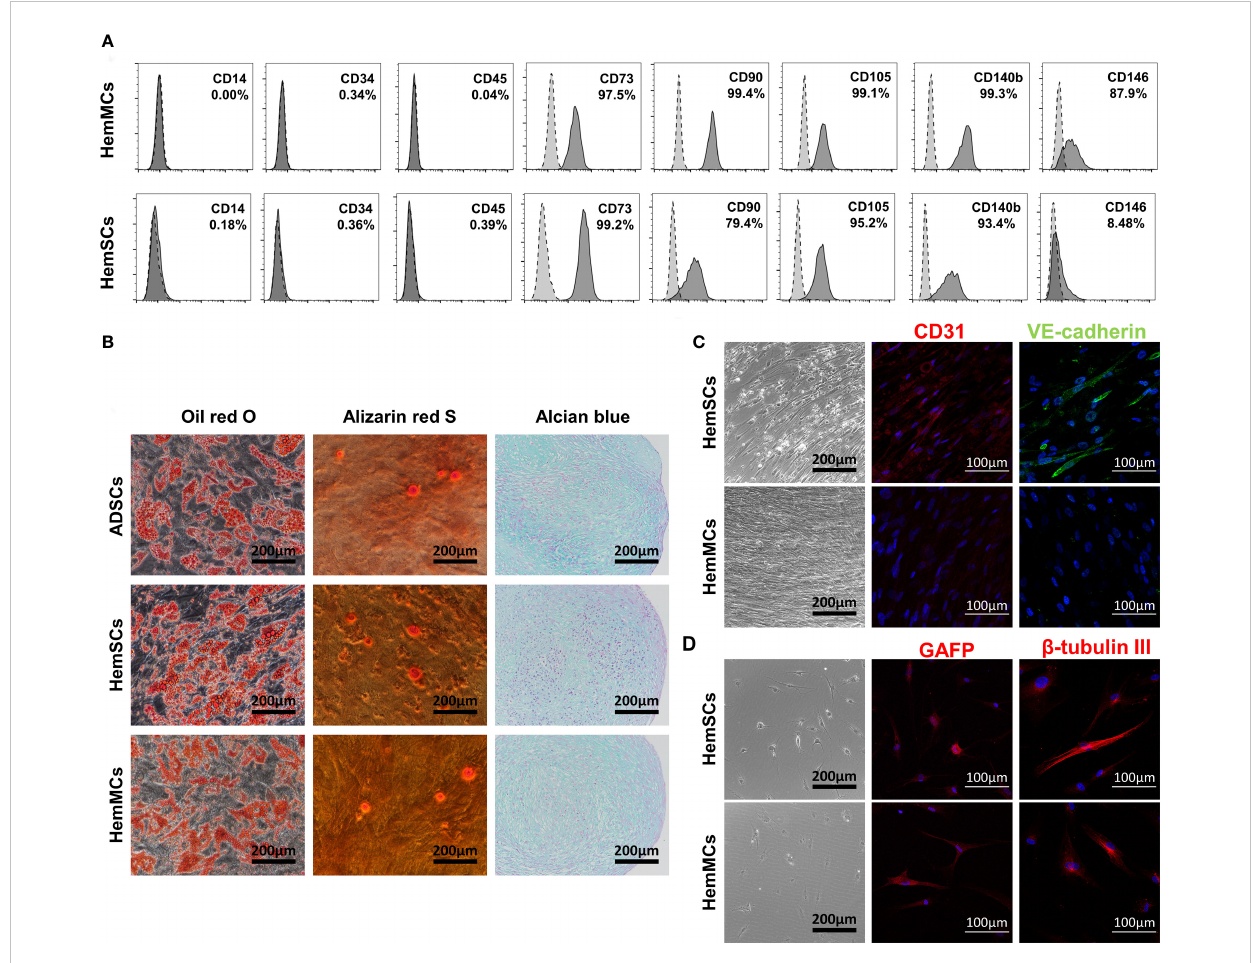
FIGURE 3 HemMCs express MSC markers and display multilineage differentiation potential. (A) Flow cytometric analysis of MSC marker expression in HemMCs and HemSCs. The dark gray histograms show cells labeled with fl uorescein-conjugated antibodies. The light gray histograms show the negative control. The percentage of positive cells relative to total cells is shown. (B) In vitro differentiation of HemMCs into oil red O-stained adipocytes, alizarin red S-stained osteocytes and alcian blue-stained chondrocytes compared with HemSCs. ADSCs were also cultured in the same medium as a positive control. Scale bars=200 m m. (C) In vitro differentiation of HemMCs into CD31 (red)- or VE-cadherin (green)-positive endothelial cells. Black scale bars=200 m m. White scale bars=100 m m. (D) In vitro differentiation of HemMCs into GFAP (red)- or b -tubulin III (red)-positive neuroglial